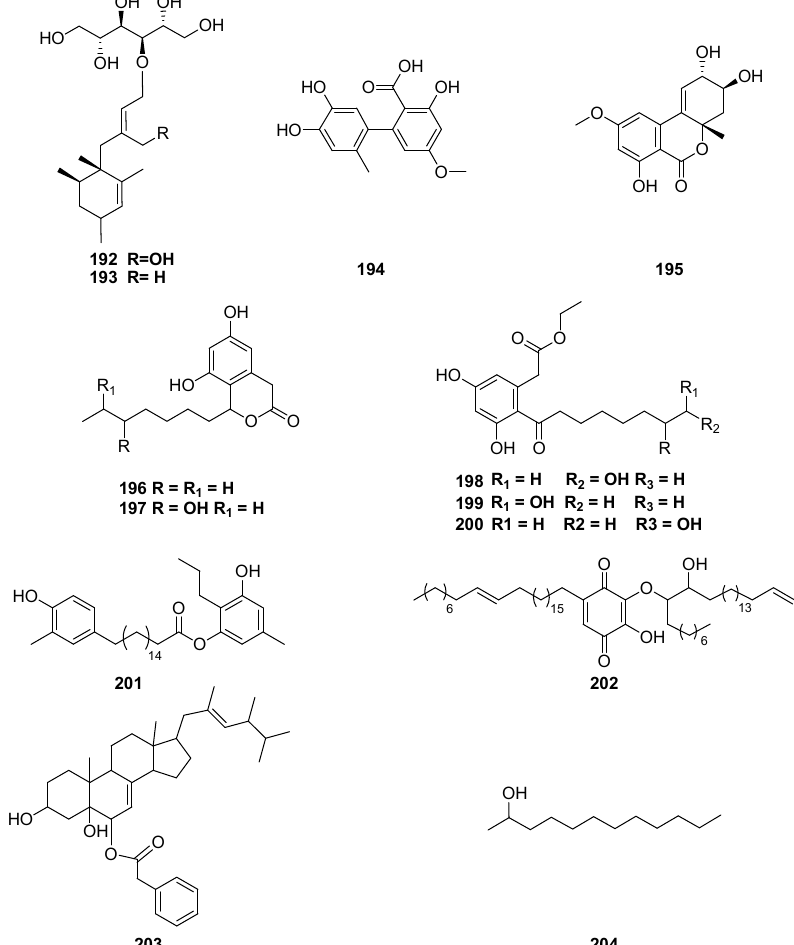
Figure 15. Compounds extracted from endophytic fungi, Stelliosphaera formicum Phomopsis spp and C. cupreum obtained from Duroia hirsute, C. arabica and Mussaenda luteola, respectively .